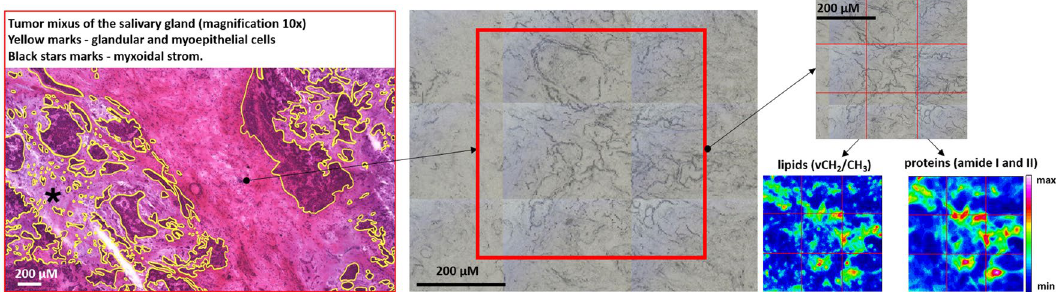
Figure 1. Exemplary microphotographs of hematoxylin and eosin (H&E) stained tumoral tissue biopsies, FT-IR microscope images, and FT-IR chemical maps distribution of lipids and proteins.